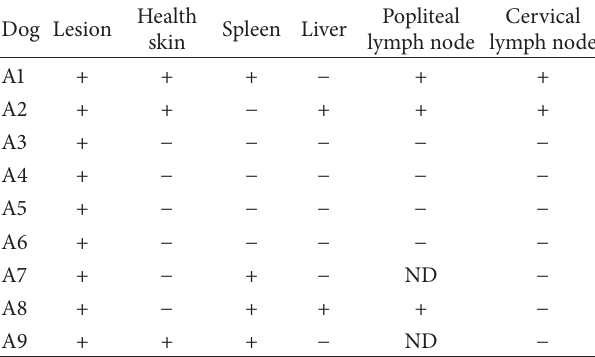
Table2:PCRresultsinthedifferenttissuefragmentsfromninedogs